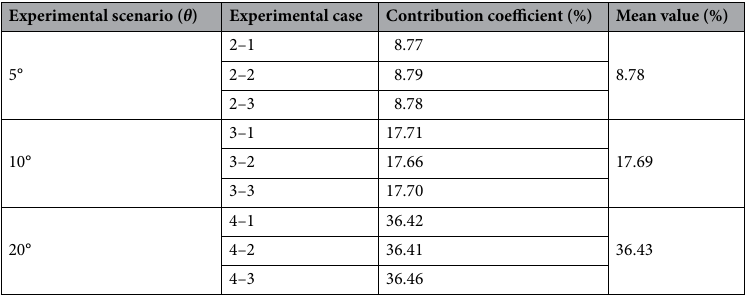
Table 3. Contribution percentage of granite specimen shear strengths (α) at different inclination angles (contribution coefficient was equal to zero at an inclination angle of 0°).